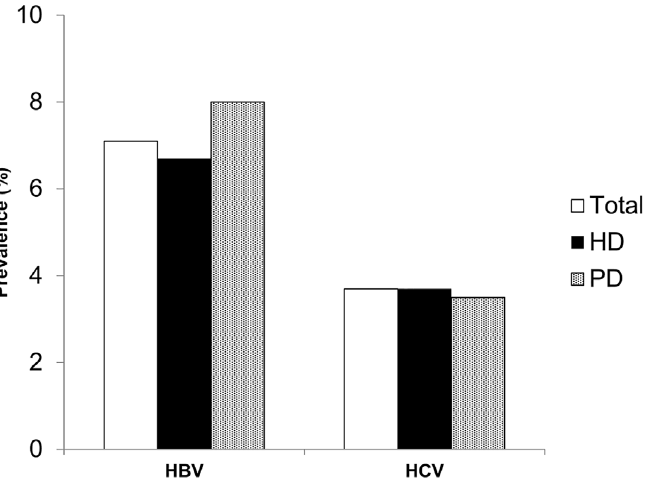
Fig 1. Prevalence of viral hepatitis infection according to dialysis modality. In our study population, we found a hepatitis B virus (HBV) infection prevalence of 7.1%, and a hepatitis C virus (HCV) infection prevalence of 3.7%. These prevalences did not significantly differ between dialysis modalities. HD, hemodialysis; PD, peritoneal dialysis.